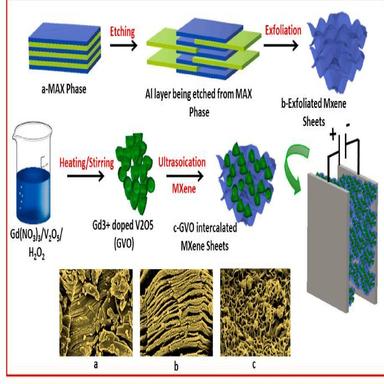
Diagrammatic illustration for the synthesis of VO, GVO and GVO/MX.